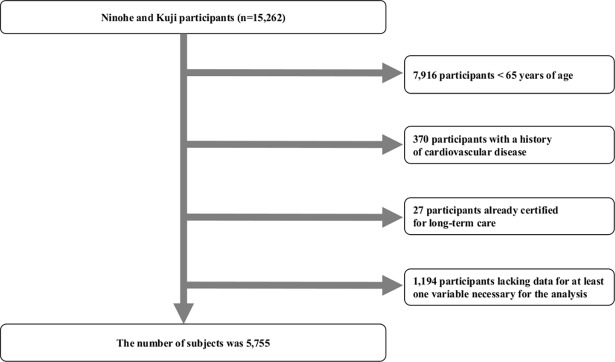
Flow chart of the procedure used to select participants for this study.The UACR, BNP, and hsCRP were measured in 15,262 participants living in the Ninohe and Kuji districts between 2002 and 2005. Among those participants, those < 65 years of age, who had a history of cardiovascular diseases (stroke, myocardial infarction or heart failure), who were already receiving LTC, or who lacked at least 1 variable for this study analysis were excluded. The final number of subjects in this study was 5,755.